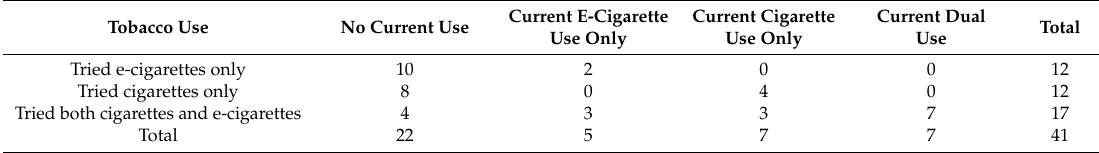
Table 2. Current use among adolescents who tried e-cigarettes or